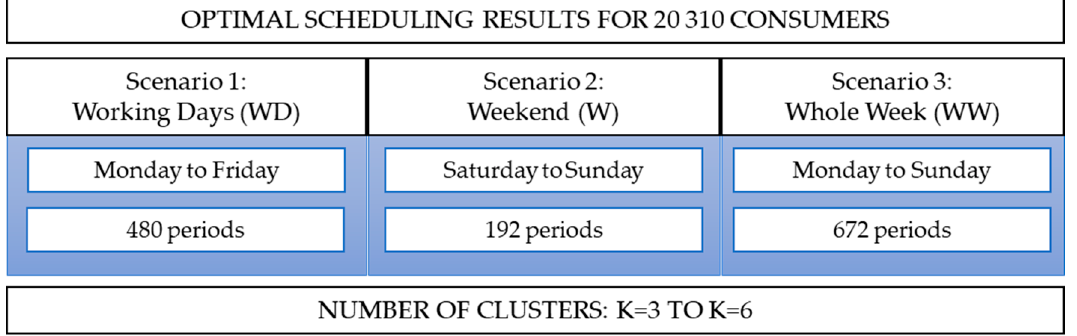
Figure 4. Different scenarios formed for the case study.